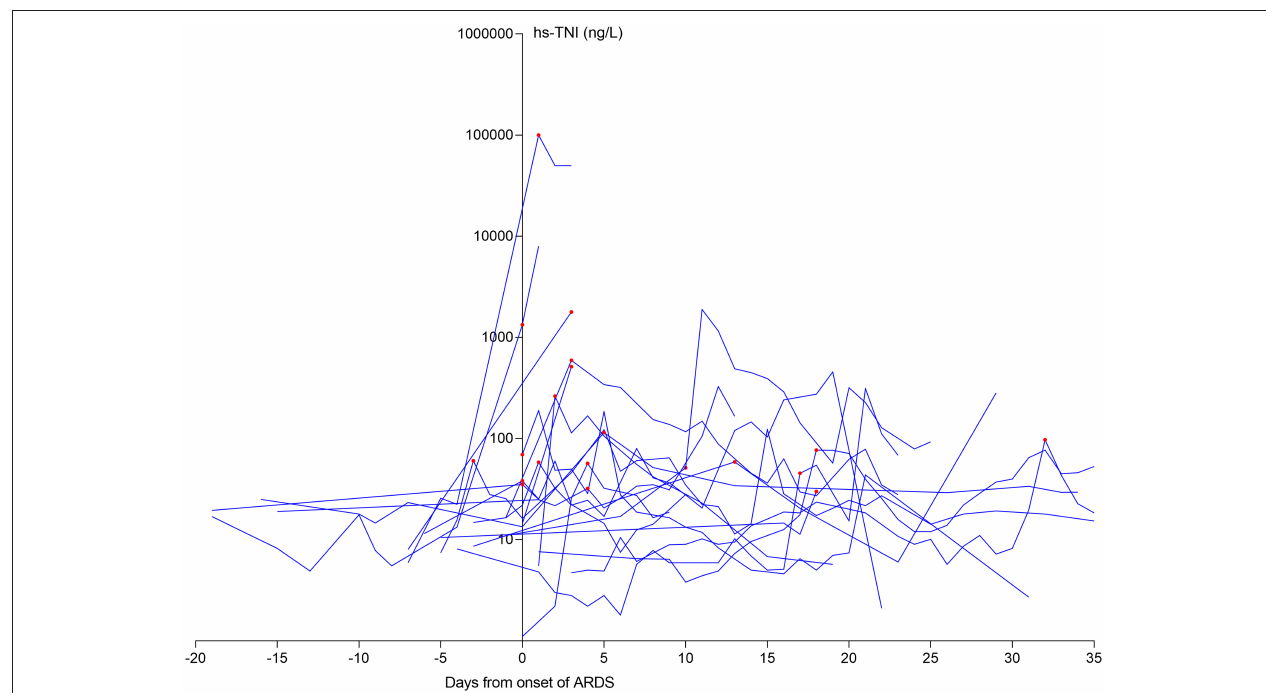
FIGURE 2 | The dynamic profile of hs-TNI levels in late CI patients in relation to ARDS onset. 15/20 (75.0%) patients suffering from late CI after the onset of ARDS. The levels of hs-TN were log transformed. ARDS, acute respiratory distress syndrome; CI, cardiac injury; hs-TNI, high-sensitivity troponin I.